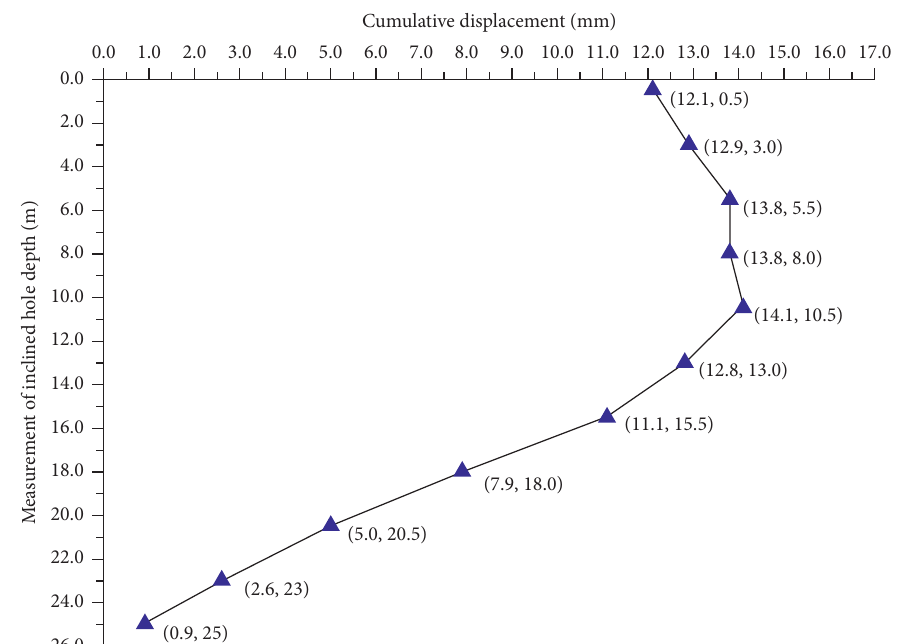
Figure 30: Inclinometer data when the wharf is excavated to the bottom.